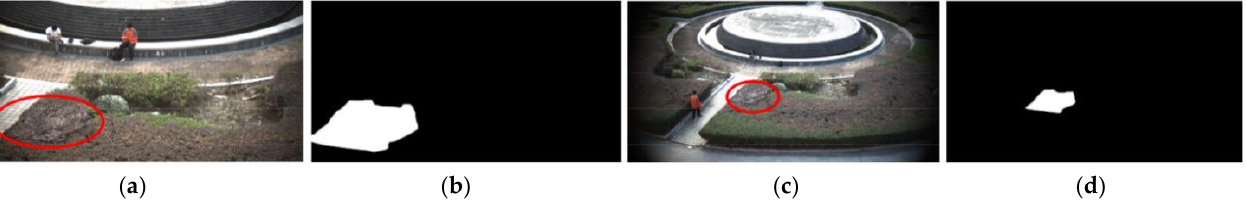
Figure 15. ( a ) The visible image of the BF scene at 35 mm focal length, where the ASRC-net is circled by the solid line; ( b ) The reference image of the ASRC-net at 35 mm focal length; ( c ) The visible image of the BF scene at 16 mm focal length, where the ASRC-net is circled by the solid line; ( d ) The reference image of the ASRC-net at 16 mm focal length.